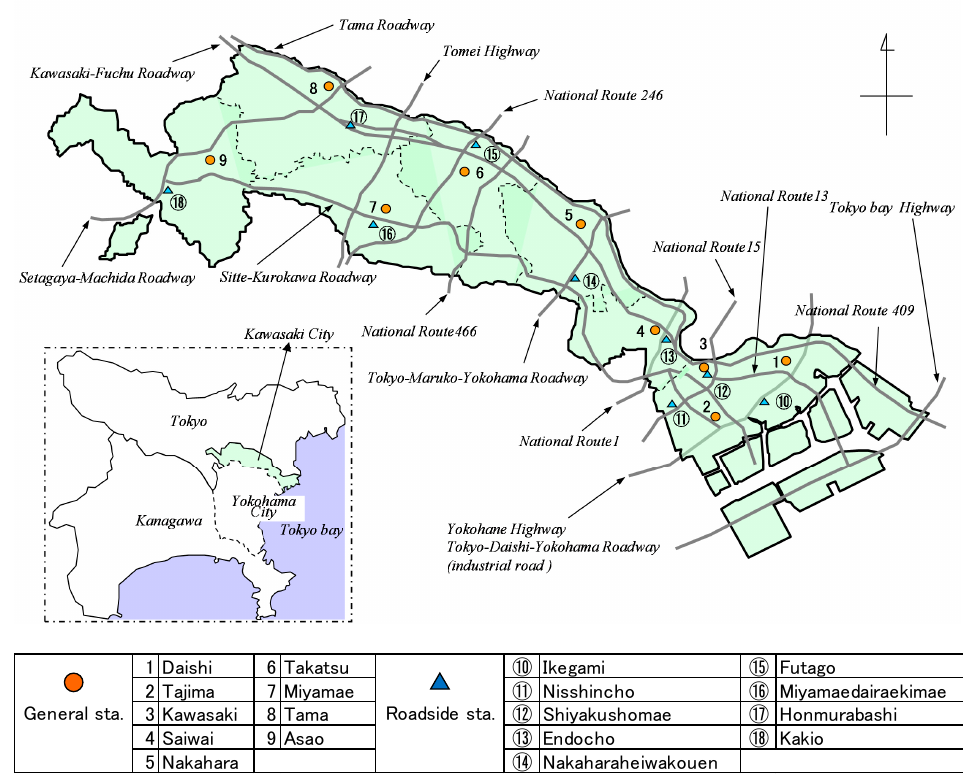
Figure 2. Locations of air quality monitoring stations in Kawasaki. In the figure, General sta. are denoted as ● and Roadside sta. are denoted as ▲ .